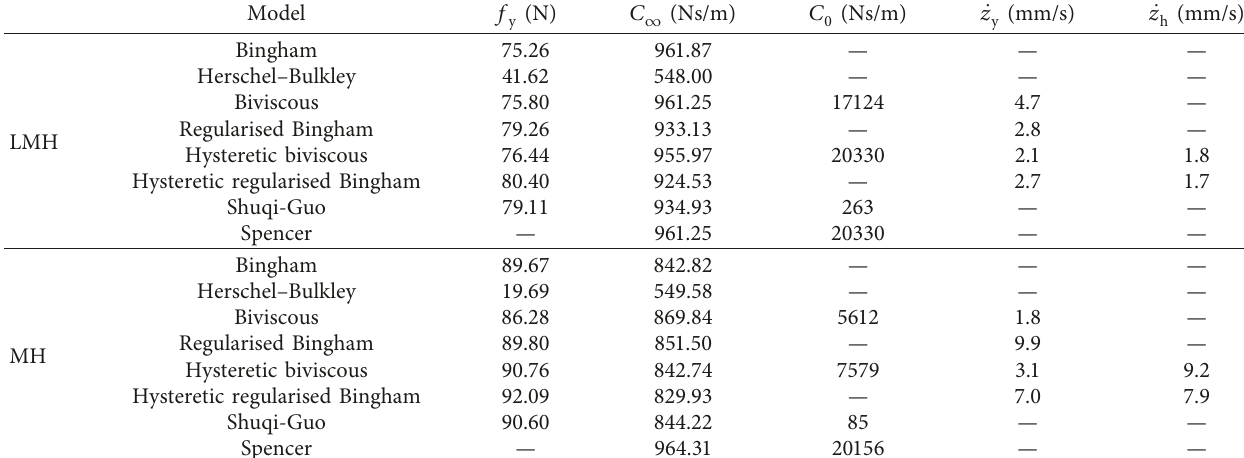
Table 1: Model parameters after fitting with I � 0A.